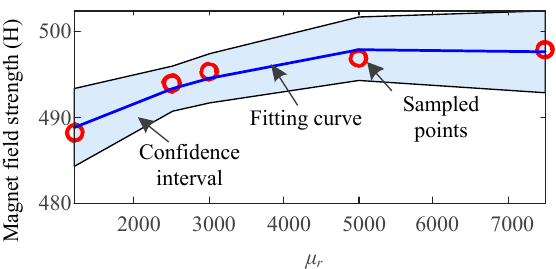
Figure 21. Fitting curve and its confidence interval of different relative permeabilities.